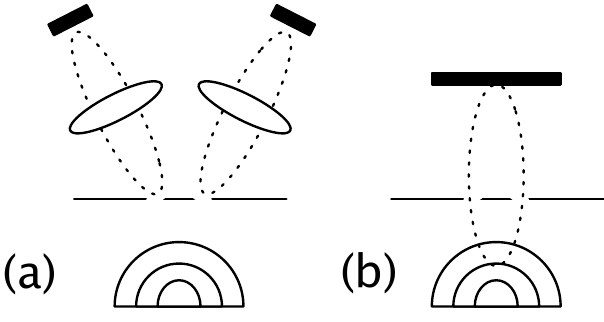
Figure 2. Two geometries of a double slit experiment, in which a single photon passes through a pair of slits. (The vertical axis is performing double-duty as both time and a second spatial axis.) ( a ) Lenses and (black) detectors measure which slit the photon passes through; ( b ) A screen records a photon that contributes to a two-slit interference